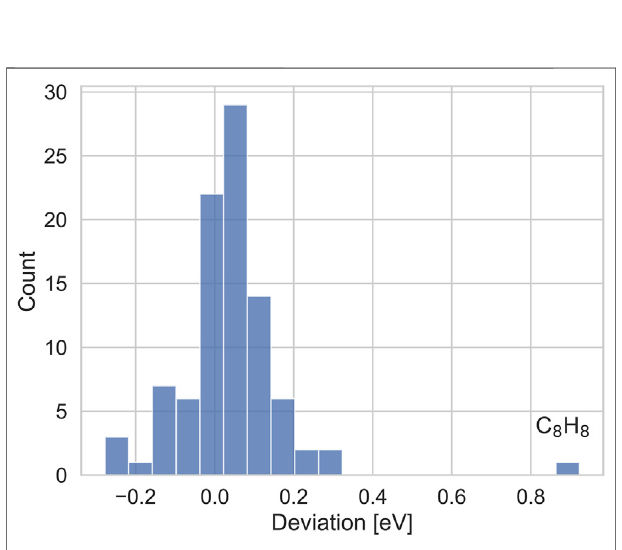
FIGURE 4 | Distribution of deviations (in eV) of the IPs from TURBOMOLE and with our implementation.